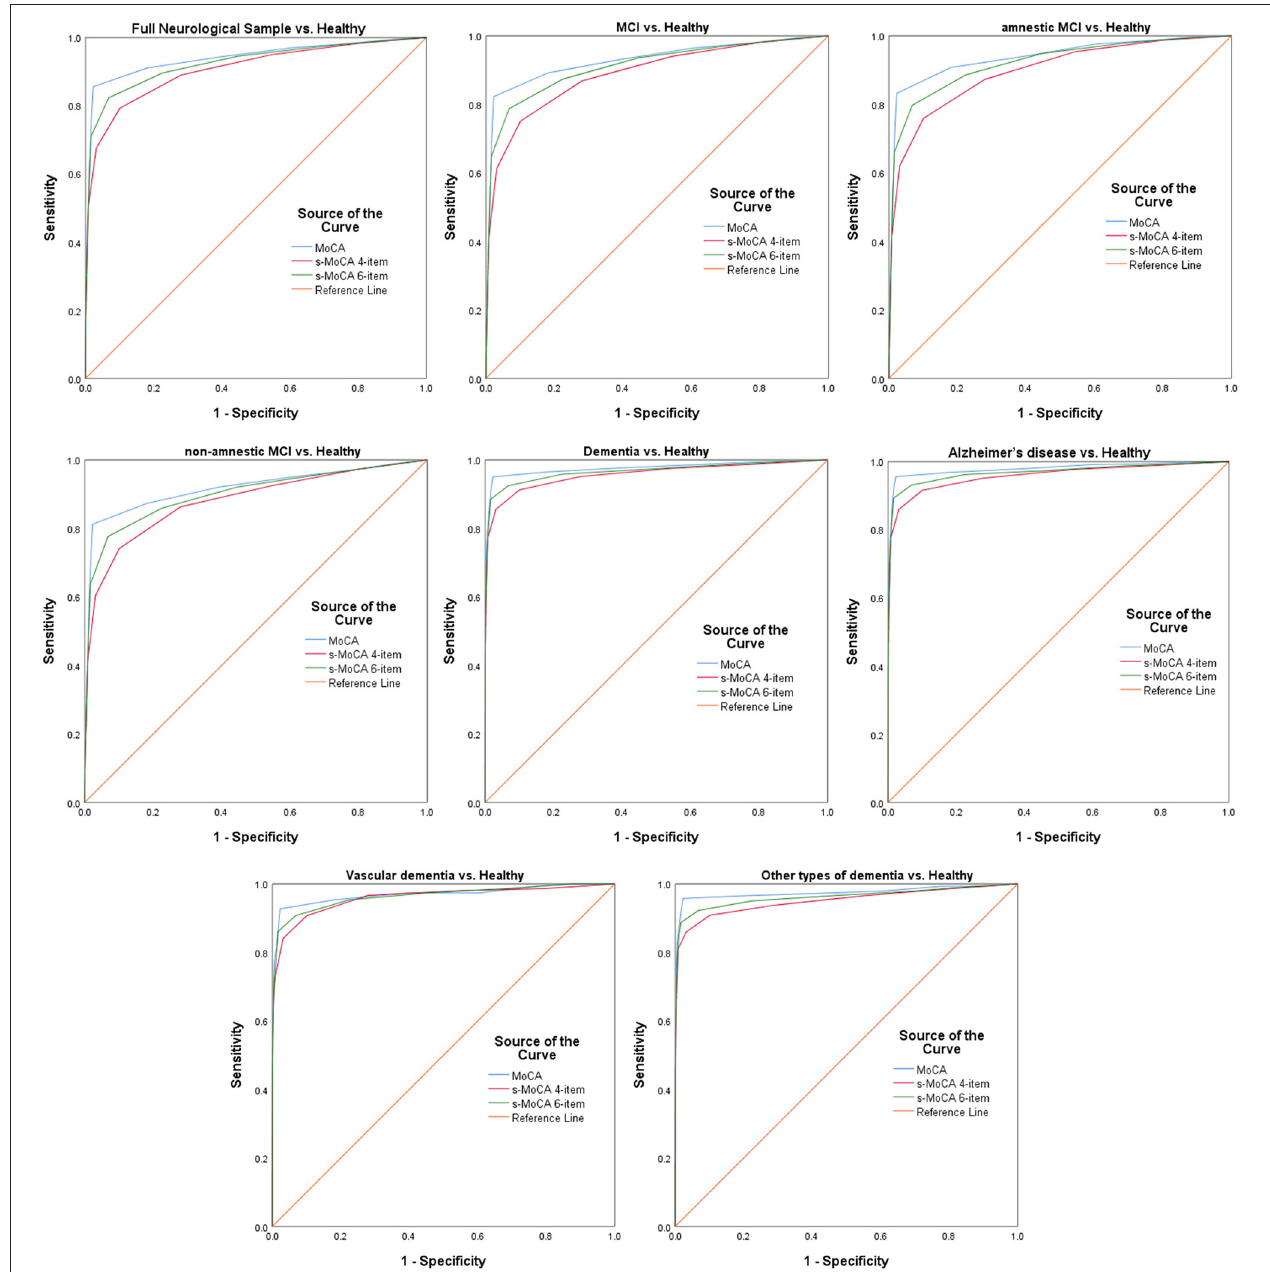
FIGURE 1 | Receiver operating characteristic curves of the standard MoCA, 4-item s-MoCA and 6-item s-MoCA; MoCA, Montreal Cognitive Assessment; s-MoCA, short-form versions of the MoCA.